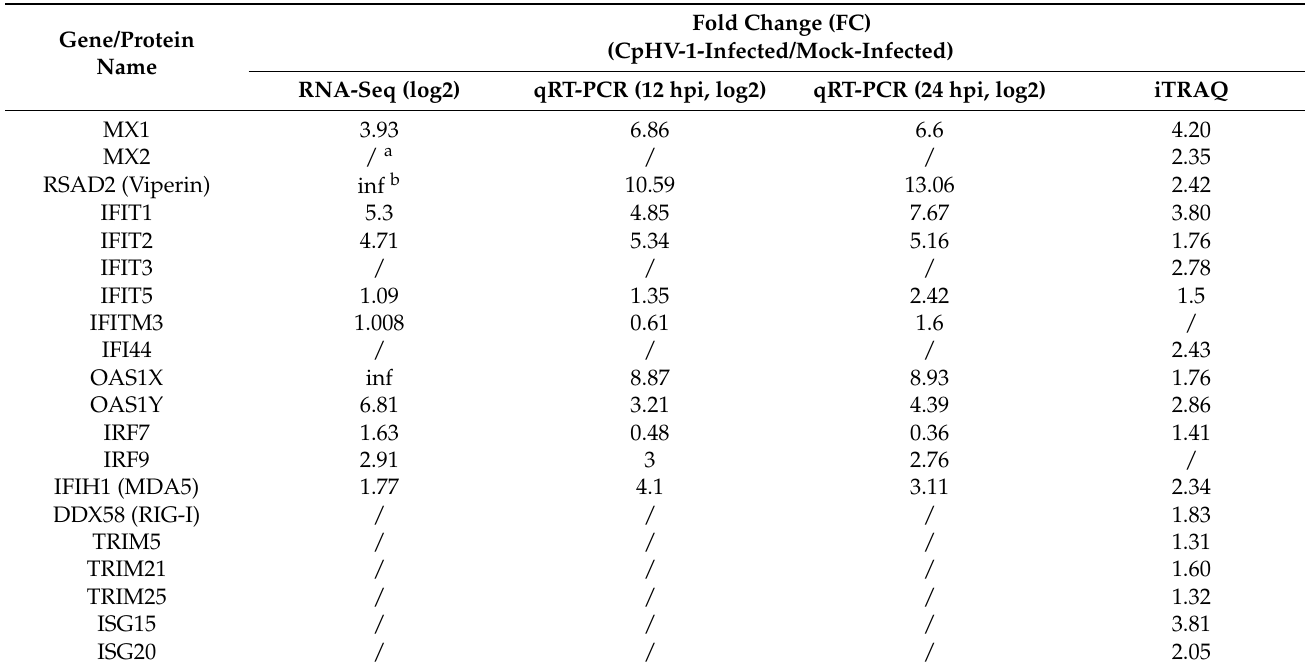
Table 3. Up-regulated targets in this